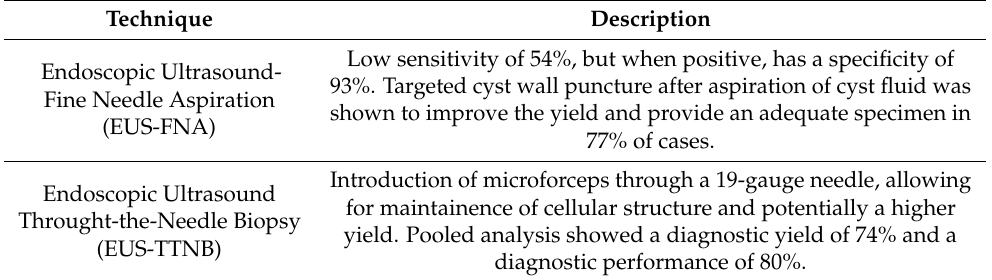
Table 4. Endoscopic Ultrasound Tissue Acquisition Modalities. Technique